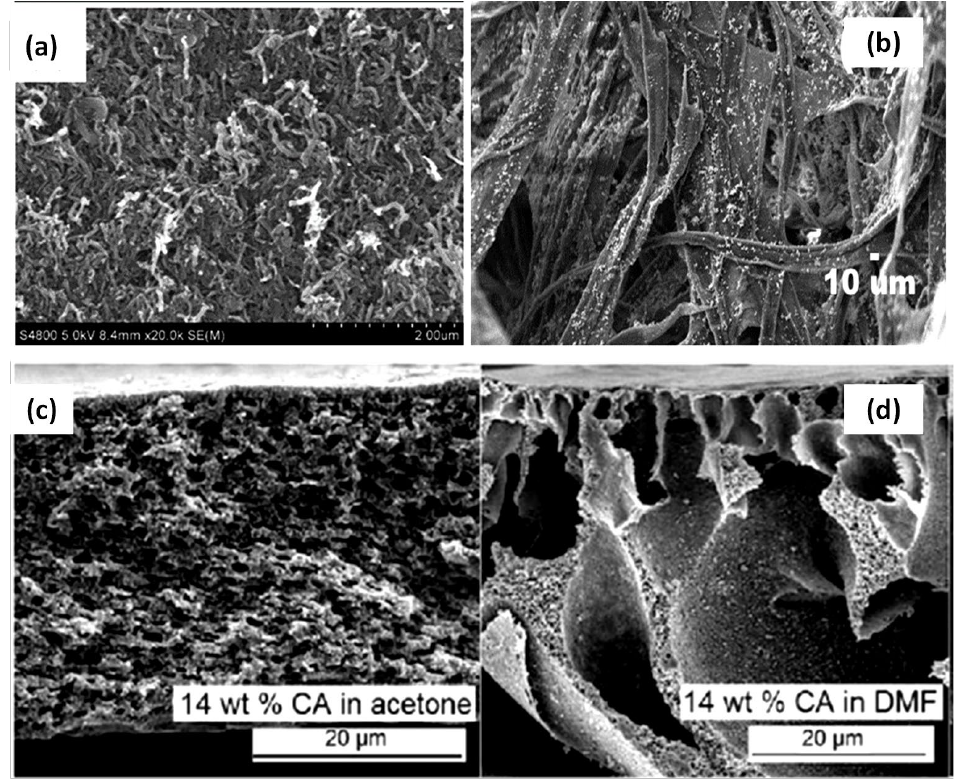
Figure 5. SEM micrographs of; ( a ) cellulose membranes incorporated with MWCNTs; ( b ) cellulose foam filter paper impregnated with ZnO nanoparticles; and ( c ) and ( d ) cross-sections of cellulose acetate membranes prepared from solutions in acetone and DMF, respectively. The micrographs were retrieved from literature: ( a ) [165], ( b ) [157], and ( c ) and ( d ) [171].